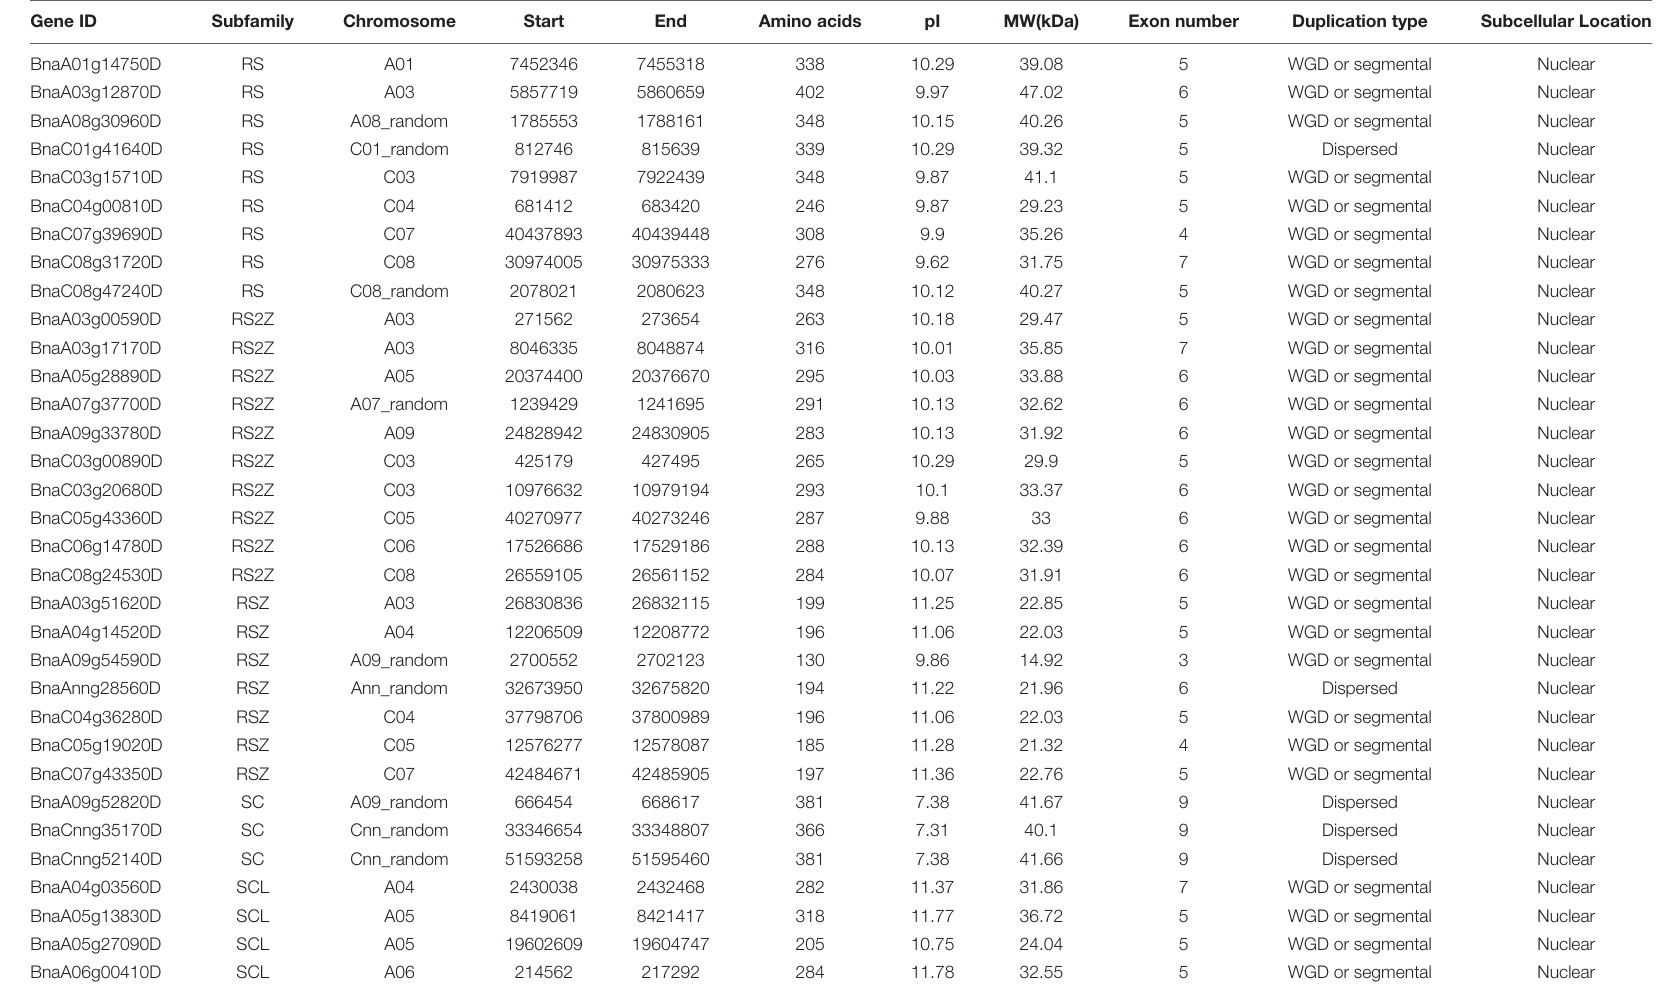
TABLE 1 | Characteristics of the SR genes in B. napus (pI, isoelectric point; MW, molecular weight). Gene